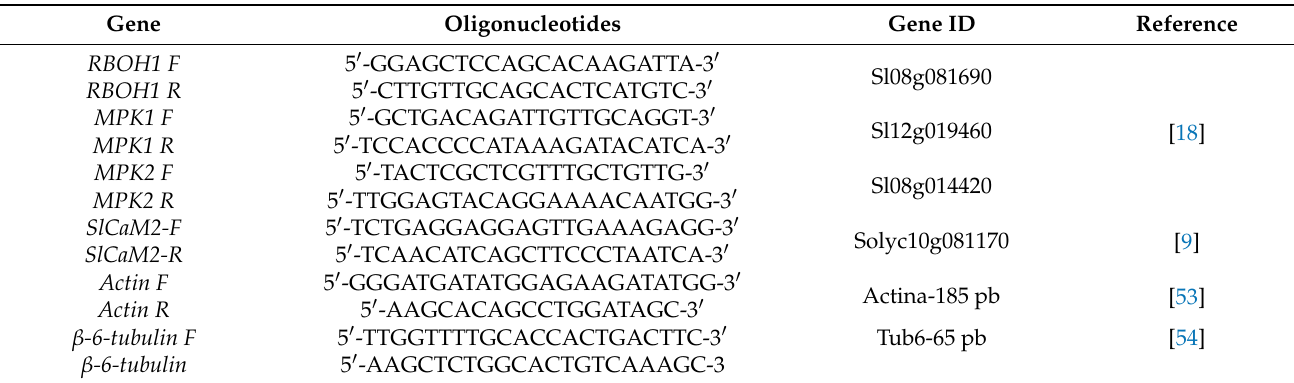
Table 1. Primers Used in Real-Time Quantification